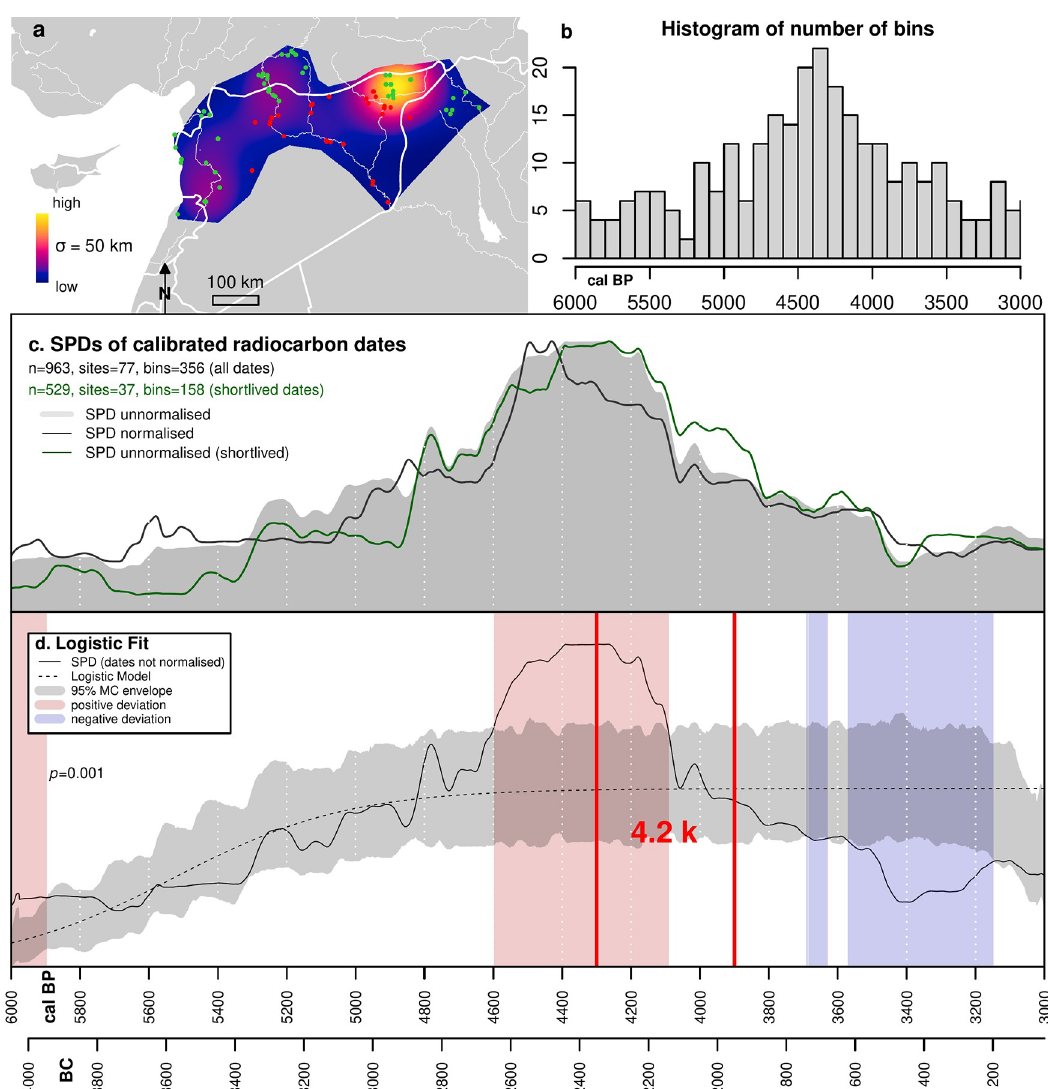
Fig 2. Summed probability distribution dataset. a: Kernel Density Estimate (50km bandwidth) of radiocarbon dates used. b. Histogram of bins and numbers of dates per bin. c: Summed Probability Distributions of calibrated radiocarbon dates. d: Summed Probability Distribution of dates superimposed on Logistic population model. Country outlines in map (a) from the GADM website (https://gadm.org/).